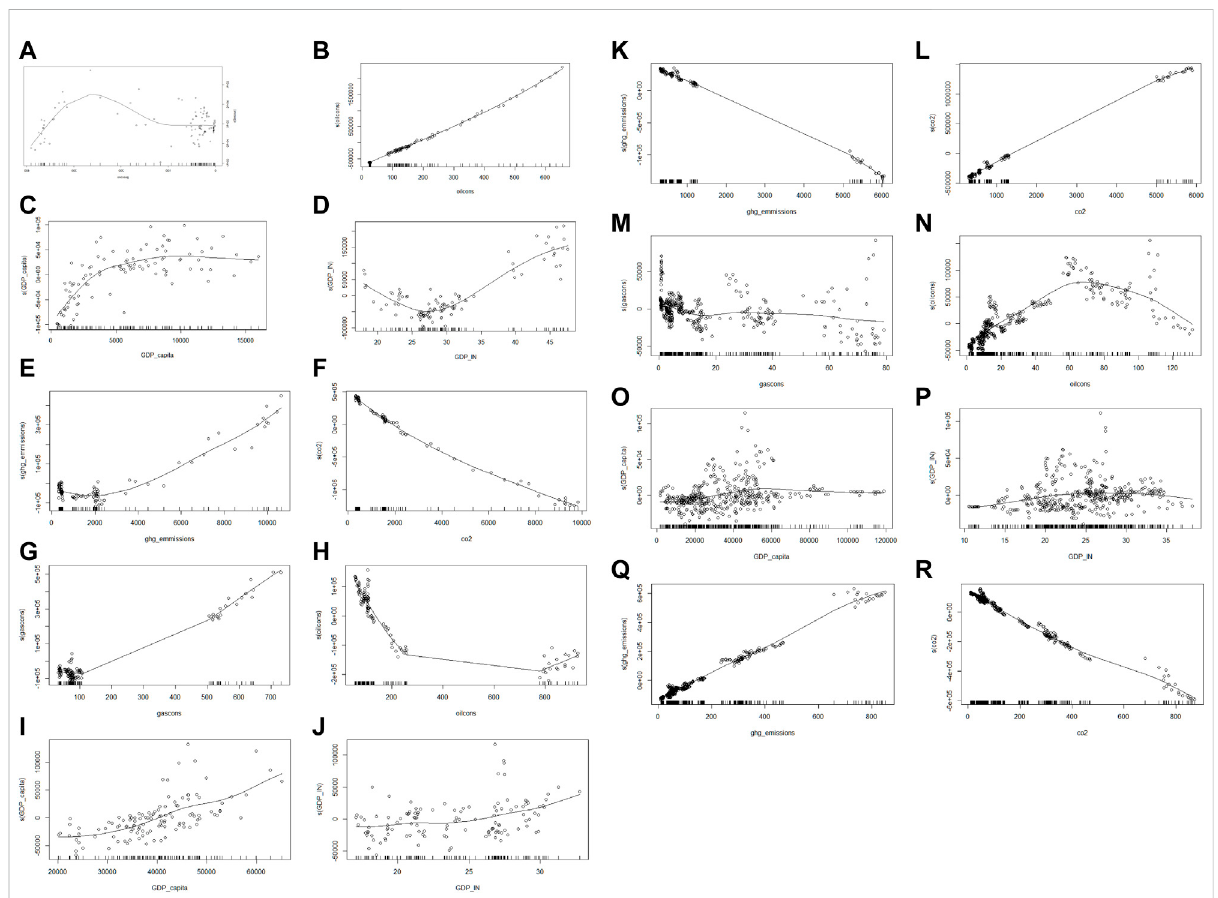
FIGURE 5 The in fl uence of several predictors over the renewable energy production capacity within the analysed geopolitical locks (A) gas consumption predictor — BRICD; (B) oil consumption predictor — BRICS; (C) GDP per capita predictor — BRICS; (D) GDP from industry predictor — BRICS; (E) GHG emissions predictor — BRICS; (F) CO 2 emissions predictor – BRICS; (G) gas consumption predictor — G7; (H) oil consumption predictor — G7; (I) GDP per capita predictor — G7; (J) GDP from industry predictor — G7; (K) GHG emissions predictor — G7; (L) CO